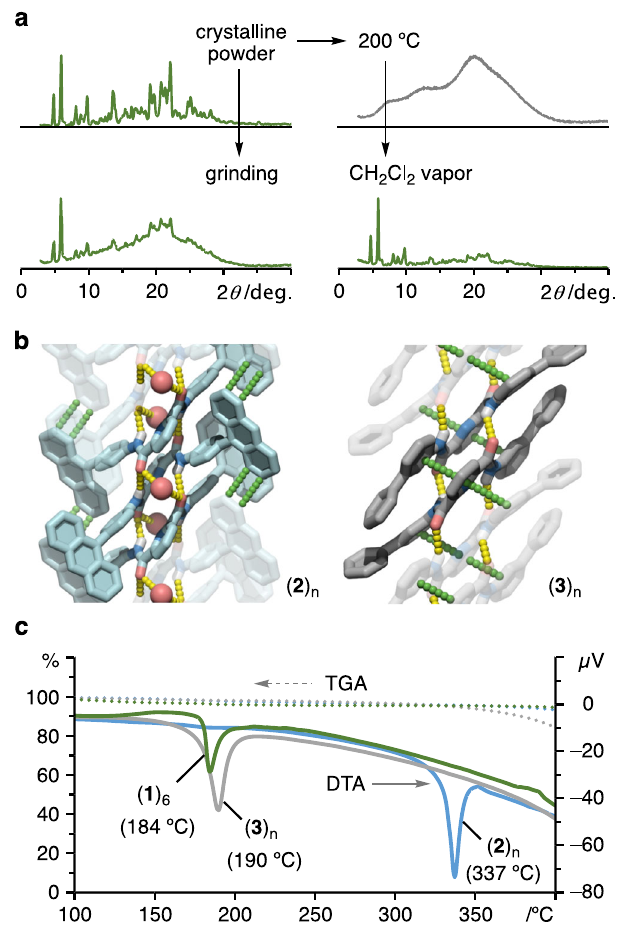
Fig. 3 | Structures and physical properties in the solid state. a PXRD patterns of the crystalline powders ( 1 ) 6 , after grinding, and the bulk amorphous powders after heating at 200°C and then exposure to CH 2 Cl 2 vapor (intensities are shown as arbi- trary units). b Packing structures of 2 and 3 in the single crystals. Yellow and green dottedlinesindicatehydrogenbondingand π - π interactions,respectively.Redballsin the ( 2 ) n network are oxygen atoms of water molecules. c TG-DTA curves of ( 1 ) 6 , ( 2 ) n , and ( 3 ) n from 100 to 400°C (dotted line: TGA curve, solid line: DTA